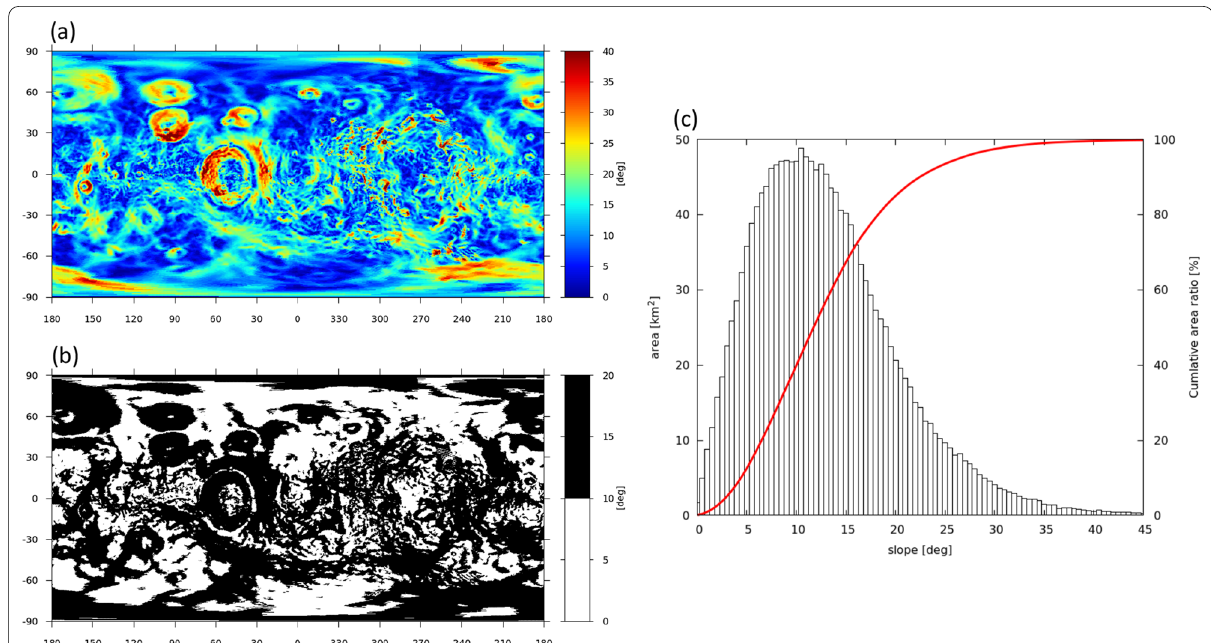
Fig. 1 a Phobos’ 2D map, color‑coded with respect to dynamic surface slope. Tidal effect is included; b binarized slope map at 10 degrees; c frequency distributions of dynamic surface slopes (bars) and its cumulative plot (red